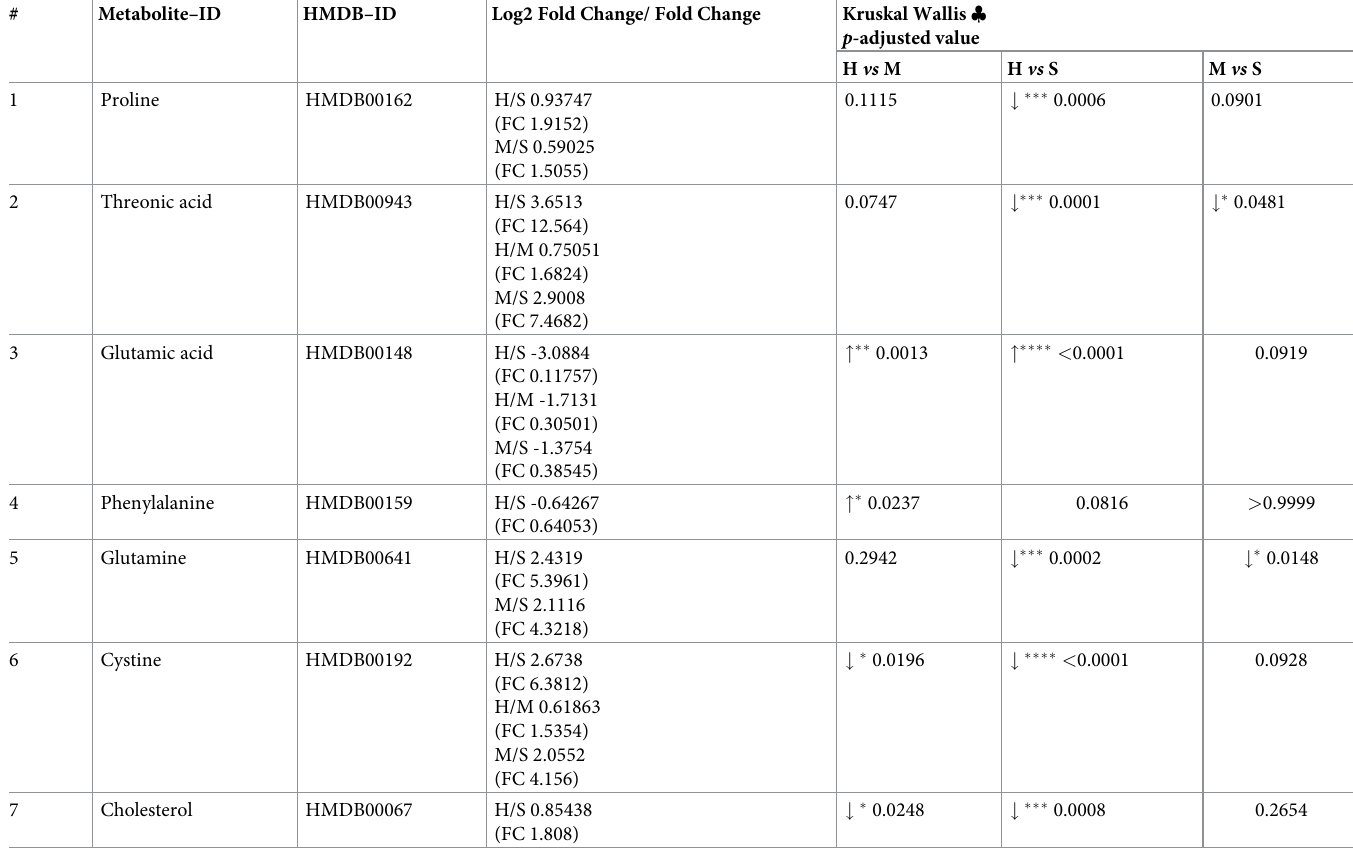
Table 2. Metabolites with significant changes between the